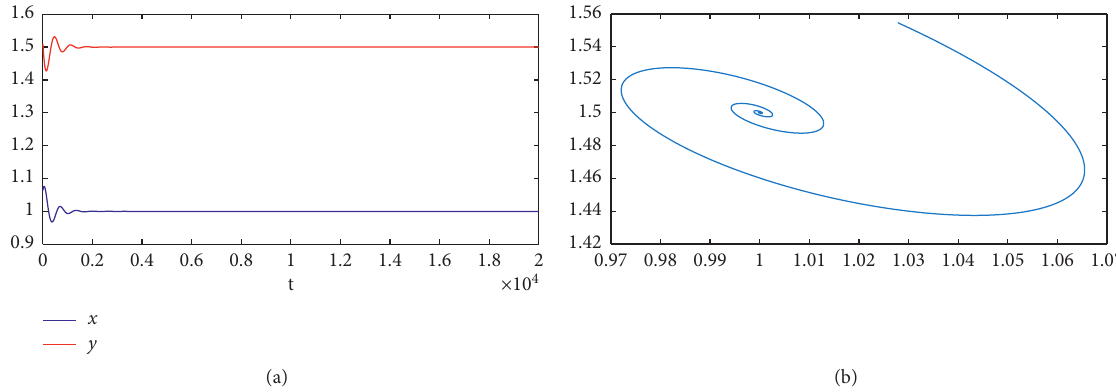
Figure 1: When the parameters a � 1 and b � 1 . 5, the equilibrium of the Brusselator system (2) is asymptotically stable. (a) The time evolution diagram of the initial value around the equilibrium point. (b) The phase plane.